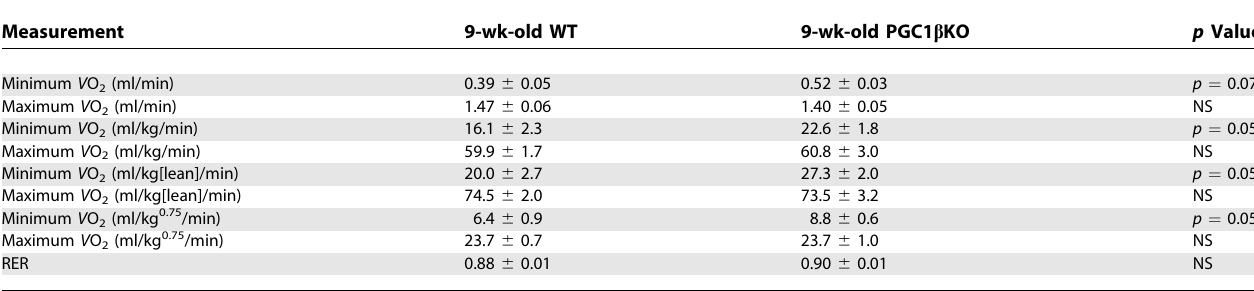
Table 1. Assessment of Energy Expenditure on 9-wk-Old Male Chow-Fed PGC1 b KO and WT Mice